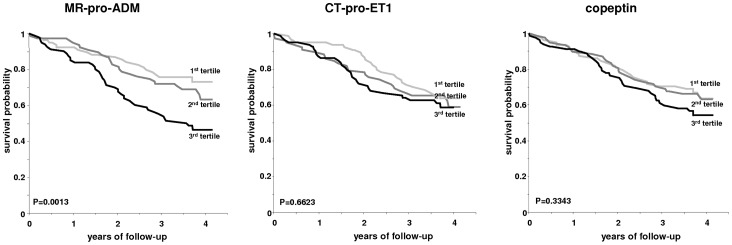
Survival curves of the cohort stratified according to the tertiles (T1, T2 and T3) of MR-pro-ADM (<1.09; 1.09–1.64; >1.64 pmol/L), CT-pro-ET1 (<131; 131–171; >171 pmol/L) and copeptin (<101; 101–171; >171 pmol/L) plasma concentration.